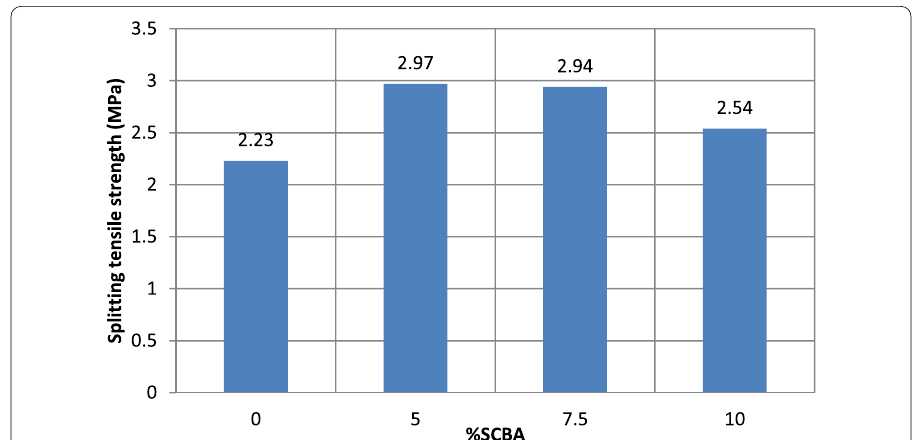
Fig. 5 Splitting tensile strength of concrete cylinders at age 28 days